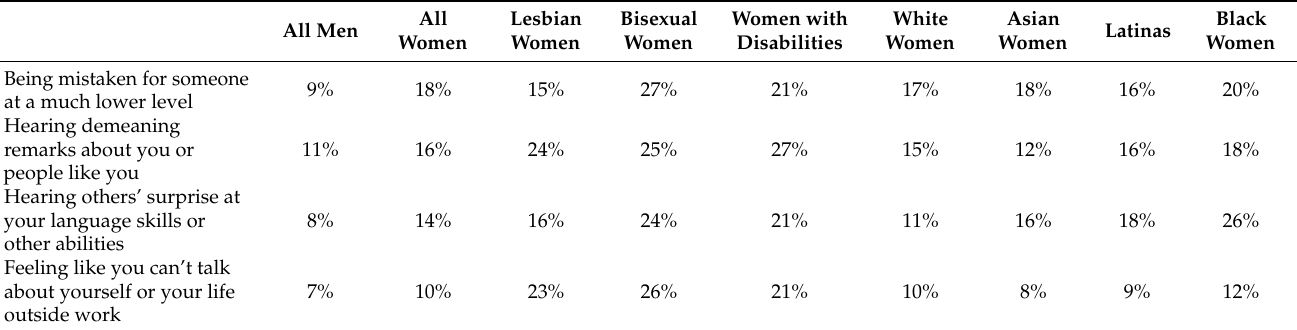
Table 1. Disrespect Experienced by Women versus